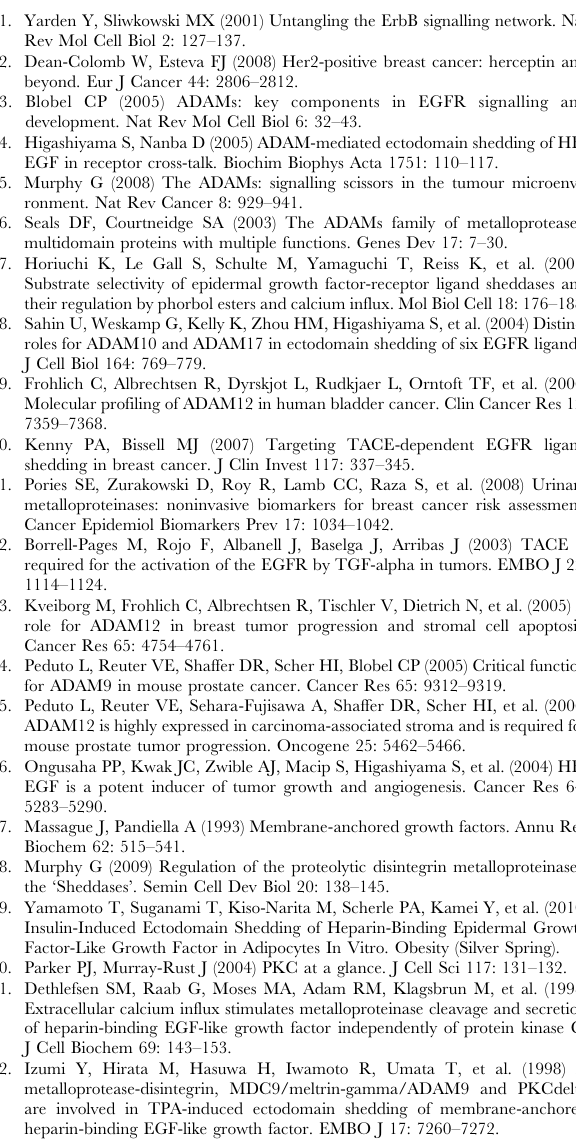
Table S1 Table showing the composition of Inhibitor Select TM 96- Well Protein Kinase Inhibitor Library I and II . Figure S1 Western blot analysis of phospho-ERK and total ERK in total cell extracts from